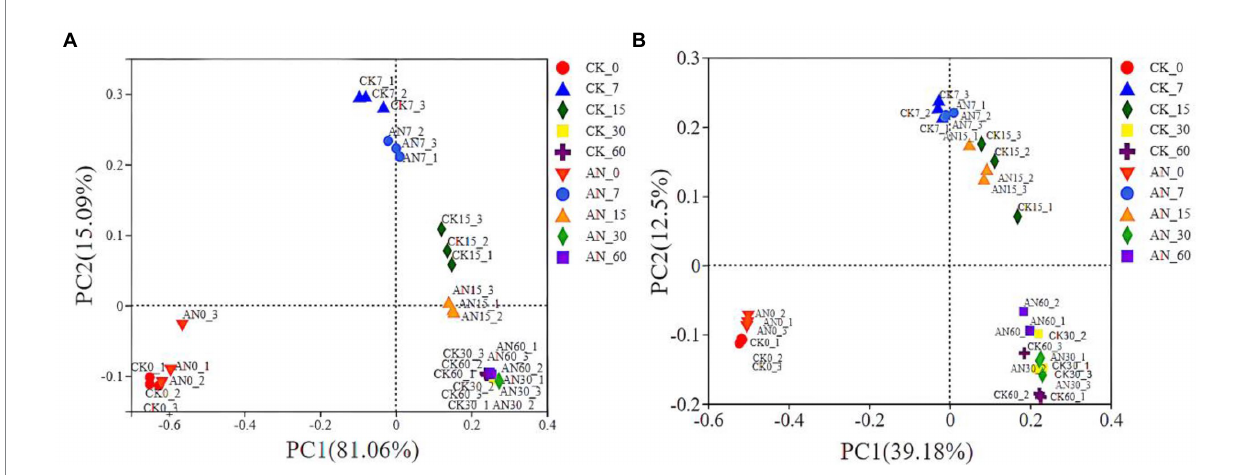
FIGURE 6 The community dissimilarities calculated by unweighted (A) and weighted (B) UniFrac distances. CK, control; AN, with A. niger .